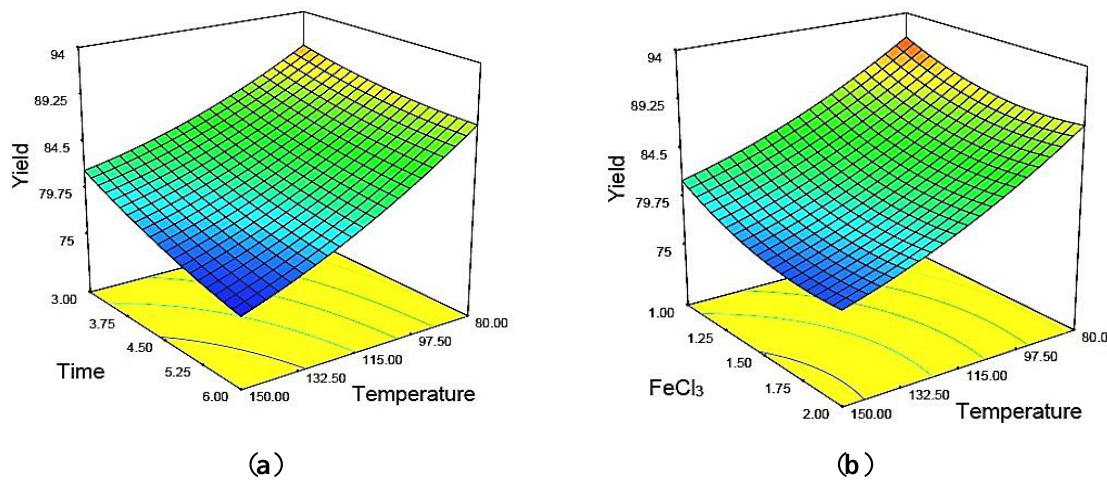
Figure 3. Response surface and contour plots of the combined effects of: ( a ) temperature and time; ( b ) temperature and catalyst concentration on the percentage yield ( y 2 ) of acid hydrolyzed MCC when the other two variables were at center points.